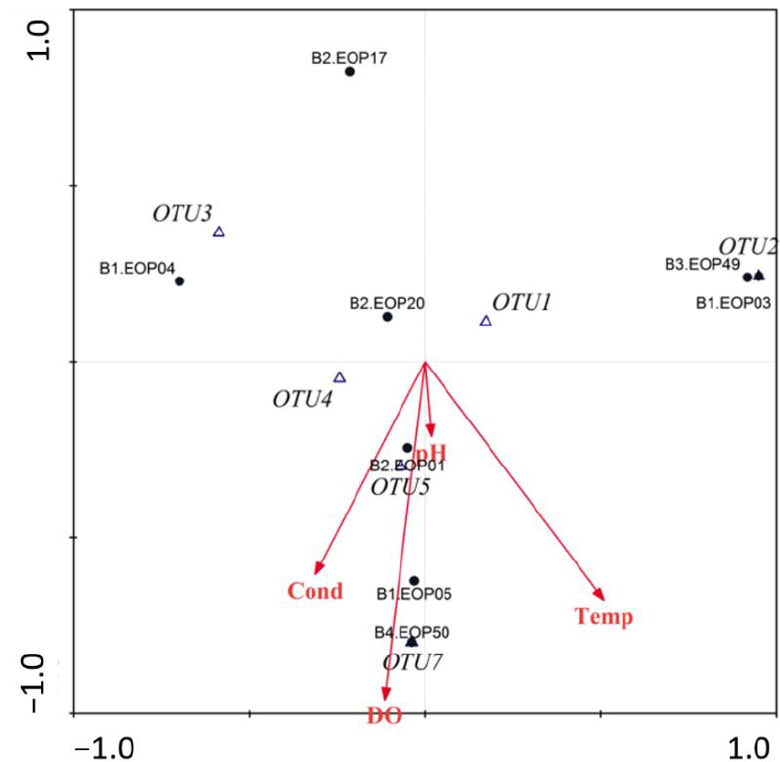
Figure 7. Canonical correspondence analysis of environmental variables and Polypedilum OTU